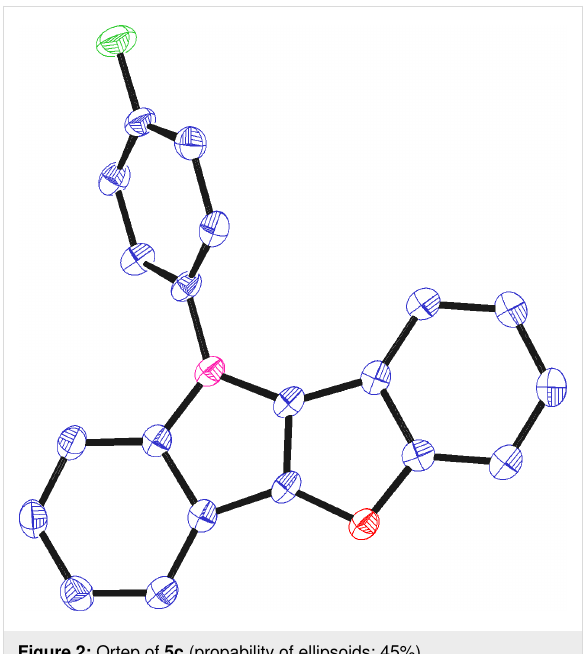
Figure 2: Ortep of 5c (propability of ellipsoids: 45%).